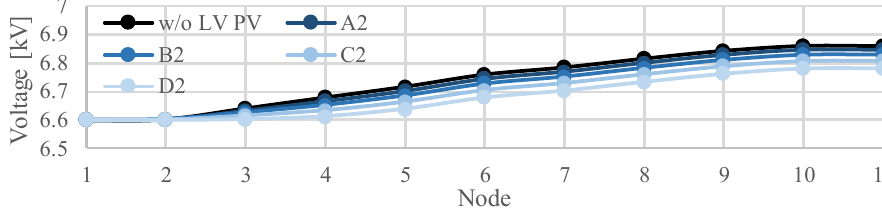
Figure 17. Voltage profile in another MV distribution feeder (power factor is set to 0.95).